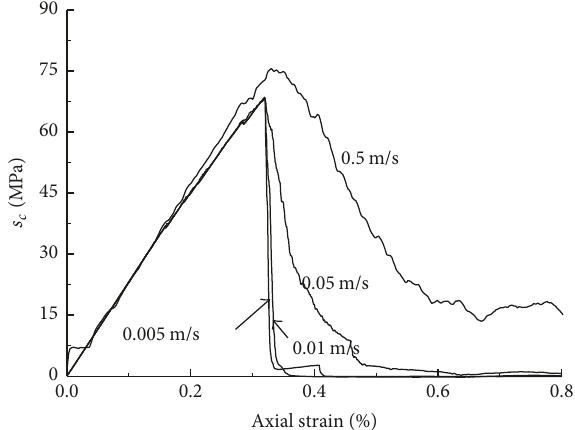
Figure6:Curveofstressversusstrainforuniaxialcompressiontests performed at different loading rates.